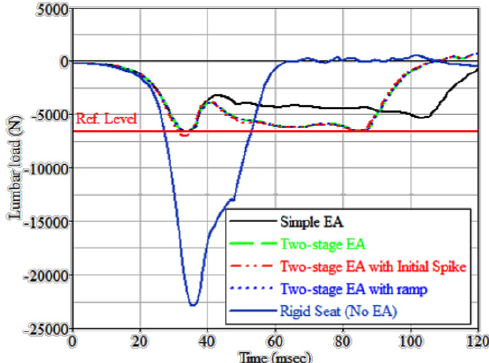
Figure 17. Comparison of occupant lumbar load for different load limiters.